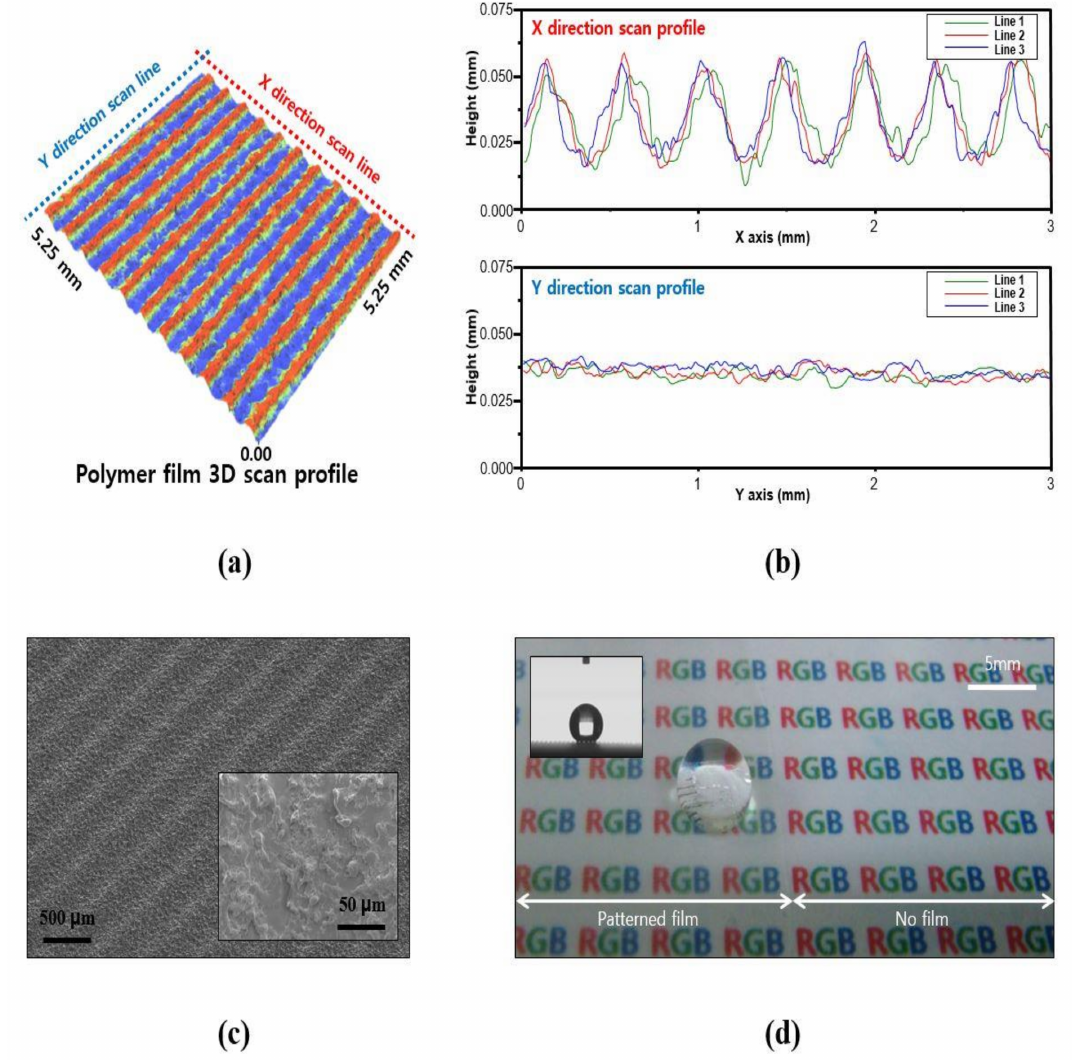
Figure 9. ( a ) Replicated polymer film corresponding to the 3D morphology image with multi-scale roughness after roll-to-roll process; ( b ) Line scan profiles of replicated polymer film surface in X and Y directions; ( c ) SEM image of replicated polymer film surface with multi-scale roughness after roll-to-roll process; ( d ) Transmittance property of replicated polymer